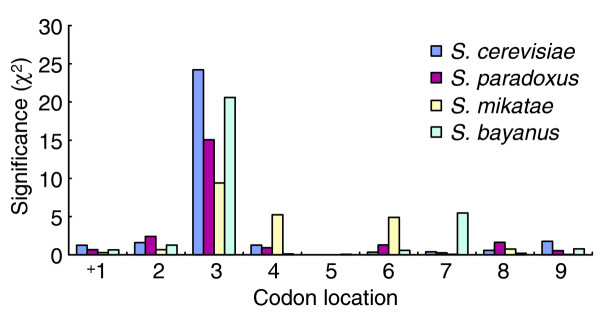
Statistical significance of the frequency of tandem stop codons. Statistical significance of the frequency of tandem stop codons following a TAA stop codon in the first nine codon locations in four Saccharomyces species is shown.